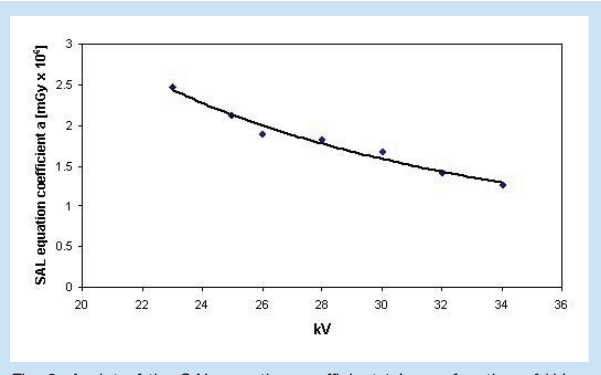
Fig. 4. lgM equation coefficient ‘b’ (Equation 4) as a function of kV (R 2 =0.944).